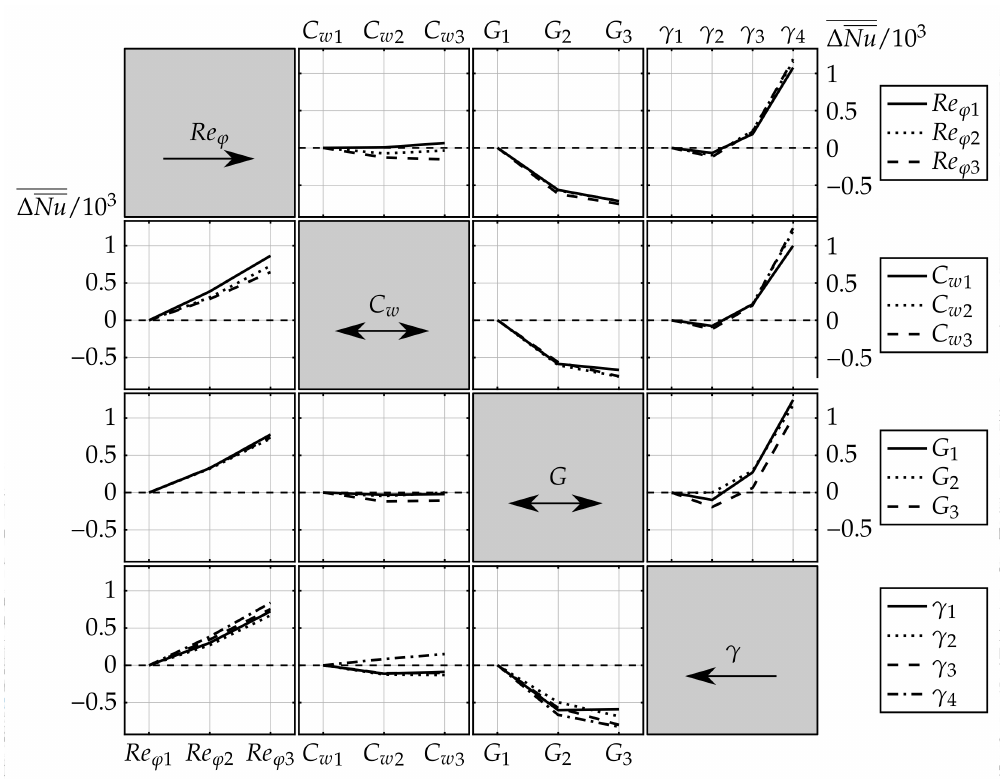
Figure 8. Illustration of the interactions between the variable parameters and their effect on the averaged global Nusselt number ∆ Nu .